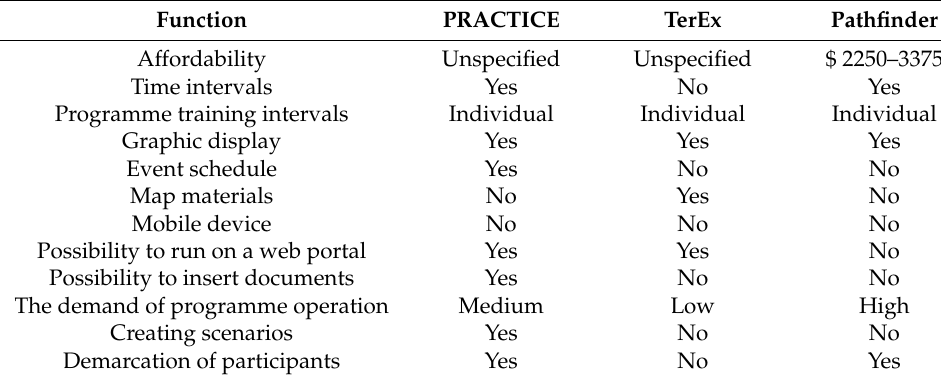
Table 1. Comparison of programme tools for the preparatory phase. Function PRACTICE TerEx Pathfinder Affordability Unspecified